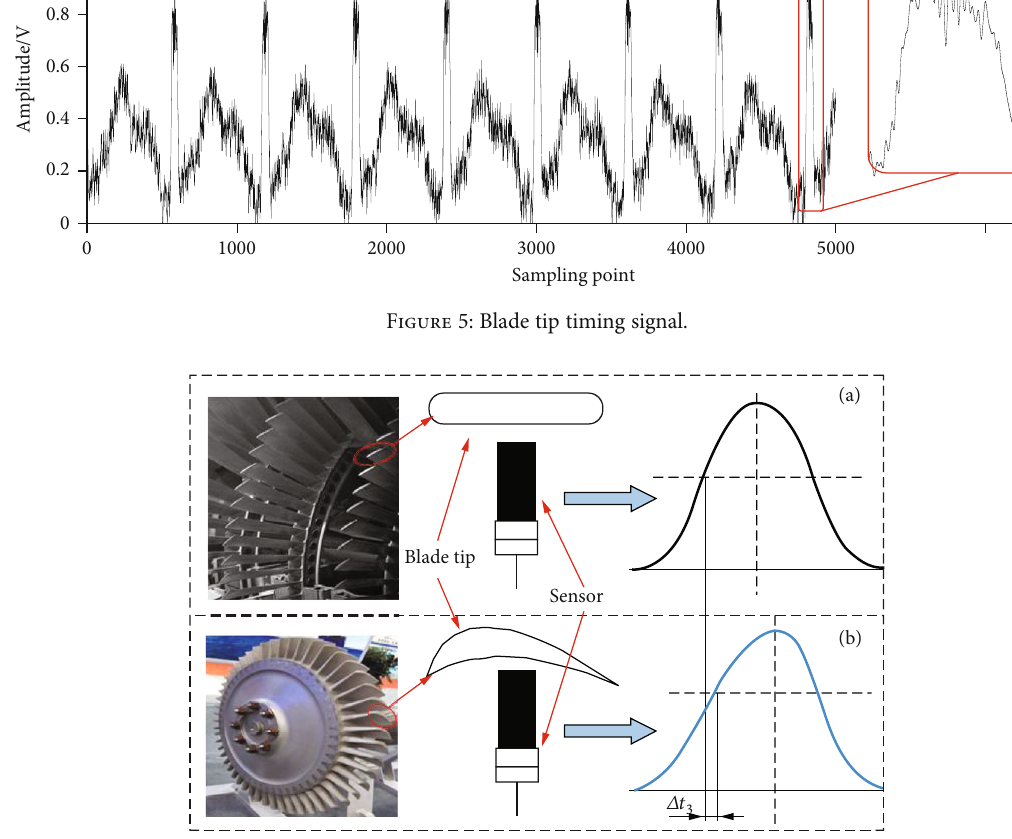
Figure 6: Measuring error introduced by the di ff erent blade tip